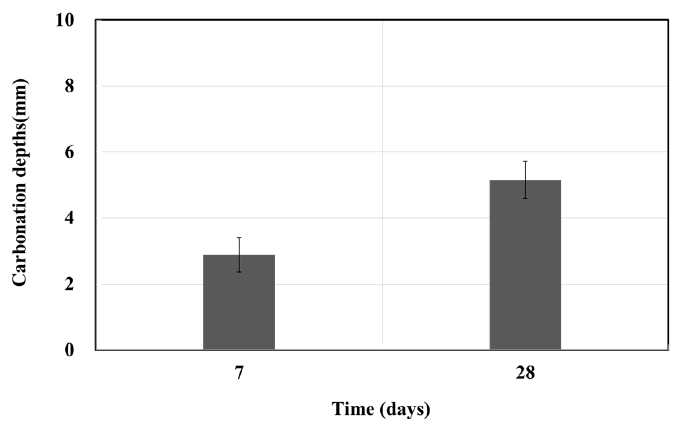
Figure 1. Accelerated carbonation